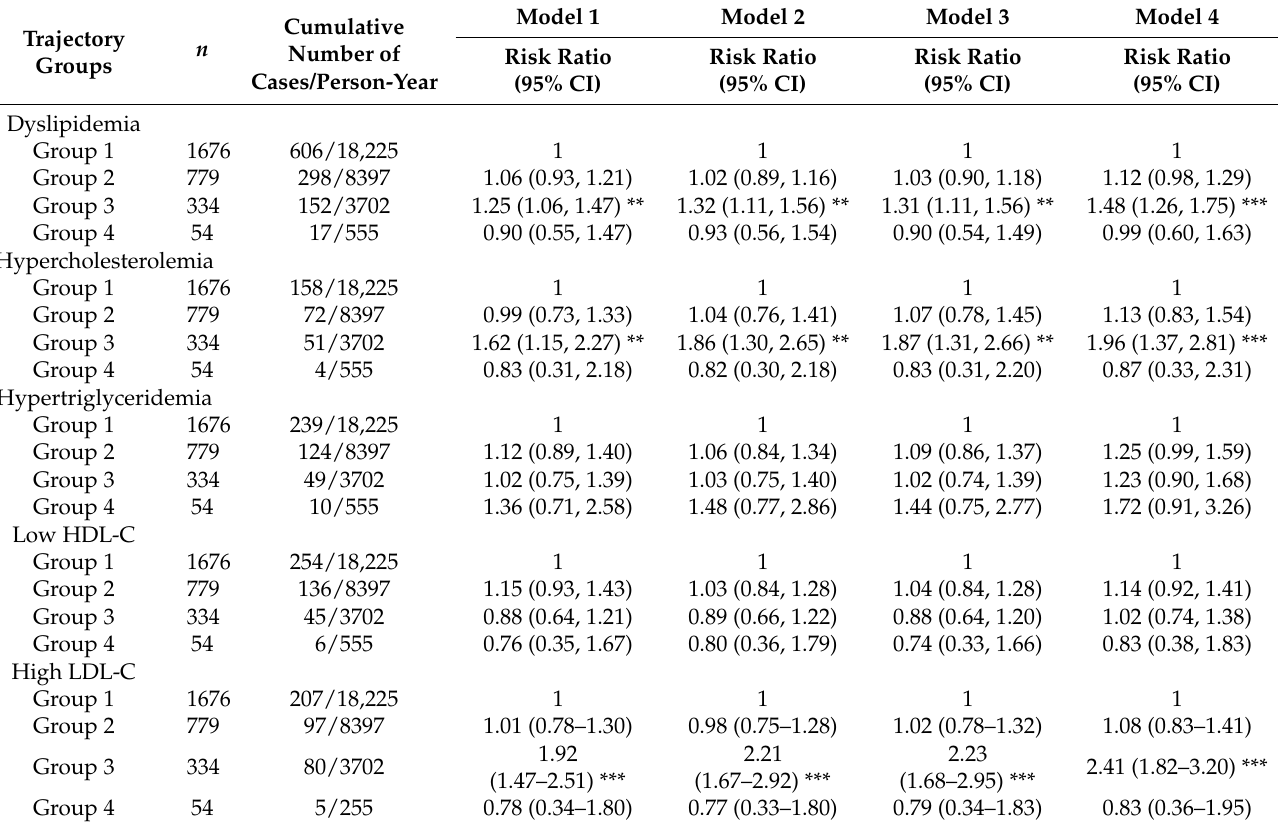
Table 2. Association between trajectory groups and risk of dyslipidemia ( n = 2843) 1 .